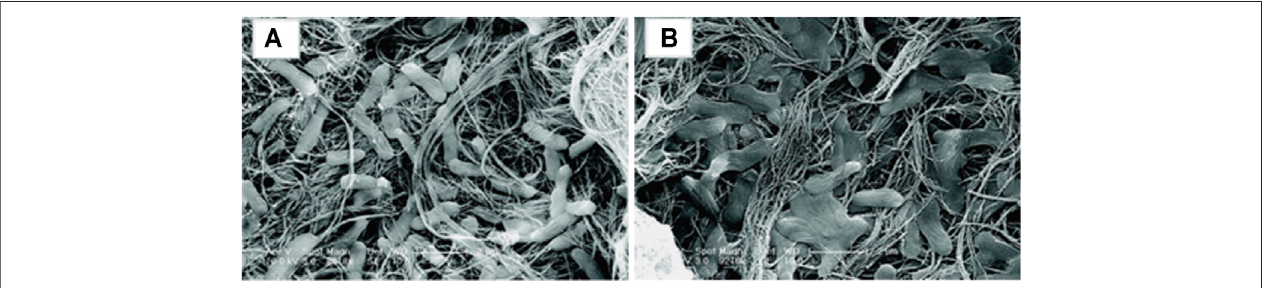
FIGURE 5 | SEM micrographs of E. coli exposed to CNTs for 60 min; (A) MWCNTs (B) SWCNTs. Reproduced with permission from (Kang et al.,